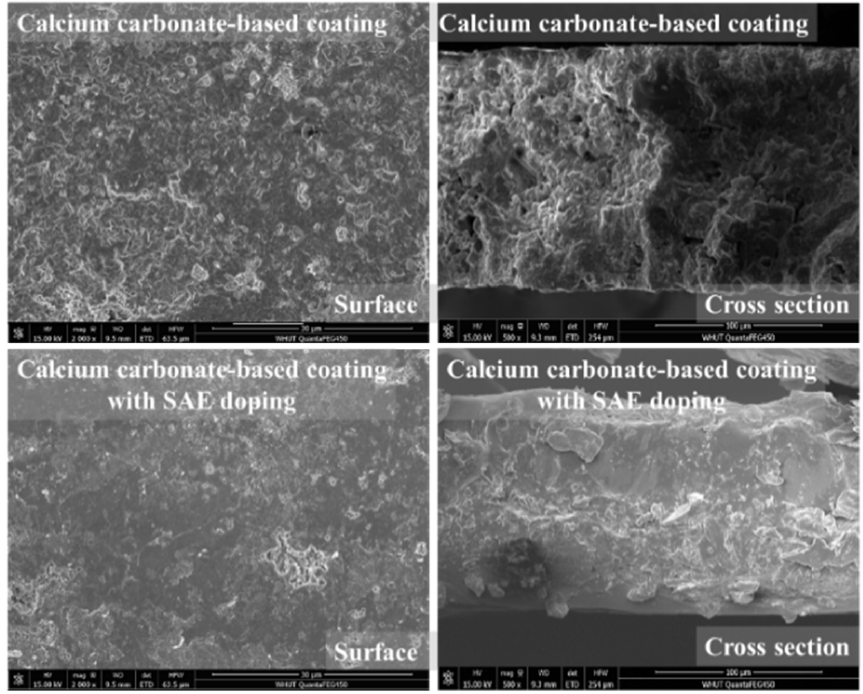
Figure 13. SEM images of surface and cross section of pure inorganic coating and 10 wt% SAE doped coating.